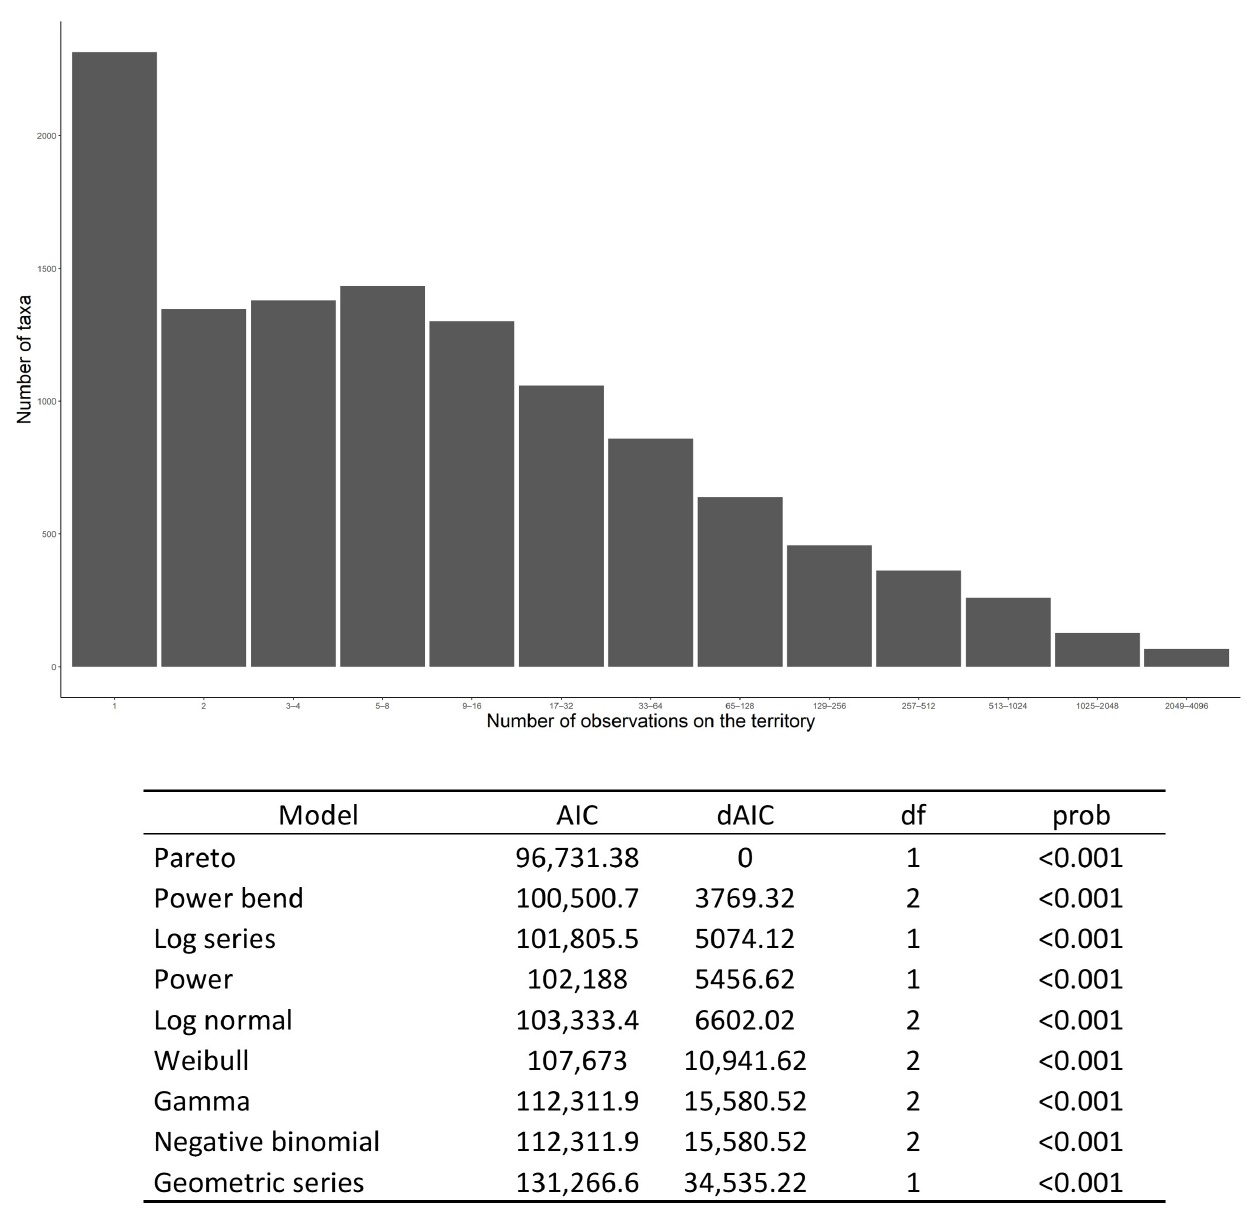
Figure 5. ( A ) Species distribution abundance (SAD) of fungal taxa in FongiBase and ( B ) Comparison of the distribution of taxa occurrence in FongiBase and nine theoretical distribution models of abundance. AIC: Akaike information criterion. dAIC: difference in AIC score between the best model and the model being compared. Df: degree of freedom. P : similarity between the observed distribution of data and the theoretical distribution of data for the corresponding